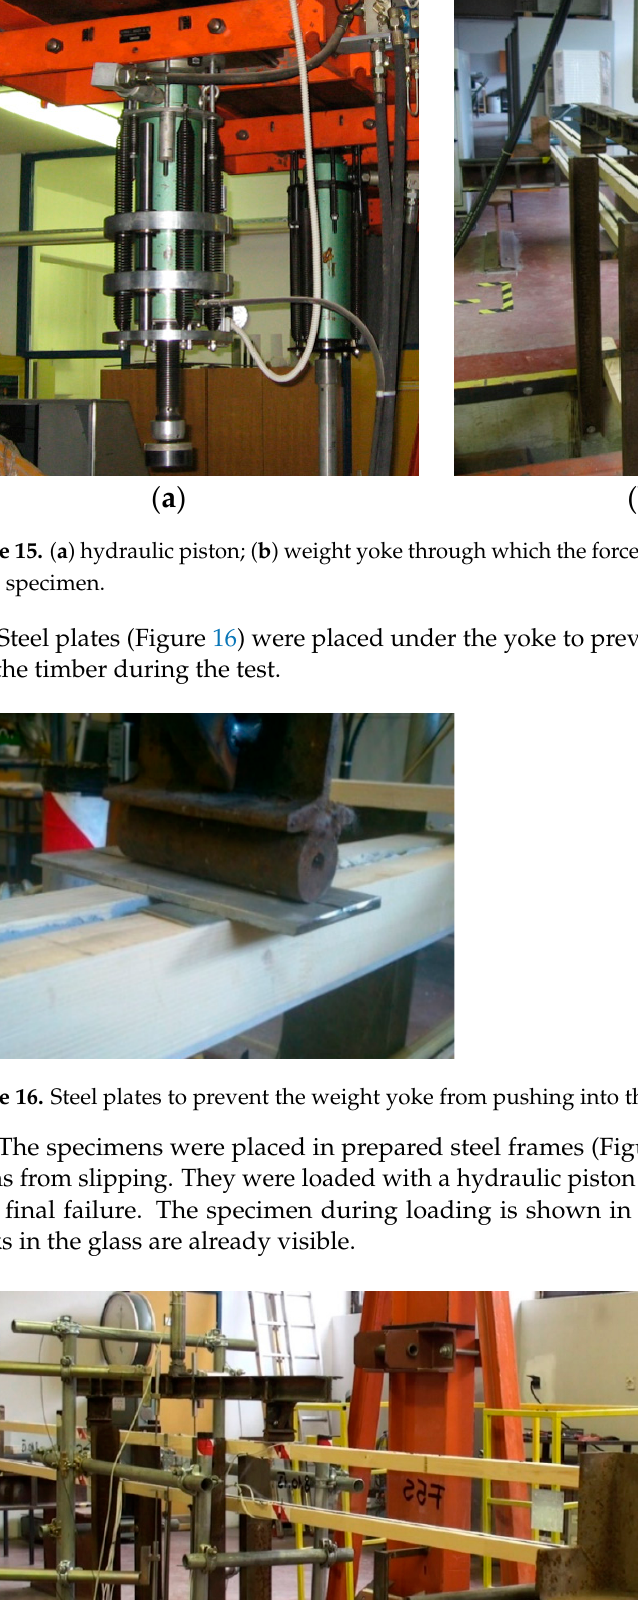
Figure 18. TGIB during four-point bending test. 3.5.2. TGIB-gf All TGIB-gf specimens were prepared also by hand. The glass plate was first cleaned with alcohol. The flange and the web were protected with a masking film before applying the adhesive. The adhesive was applied into the groove using a compressed air gun and a spatula. The flange was placed under the glass web, which was then positioned and stabilised in the groove. Rubber strips were used to ensure even uniform bonding of the adhesive line thickness. Once the tape was placed in the rubber strips were shortened and left in the groove. The stabilised specimens remained until the adhesive had cured. Unlike acrylate, which took approximately 10 min to cure, the specimens were bonded with sili- cone and epoxy adhesive for 12 h before the other flange was bonded to the glass web. 4. Results All tests were performed in the laboratory under constant conditions of temperature and humidity. The room temperature and humidity data, as well as the moisture content of the wood, were measured during the preparation of the samples and during the tests. Temperature and humidity have a great influence on the material properties of wood. Table 6 contains the measurements of relative humidity and air temperature during the preparation of the specimens (P) and during the testing of specimens (T), as well as the measured mean values of relative humidity on the wood according to each test group.